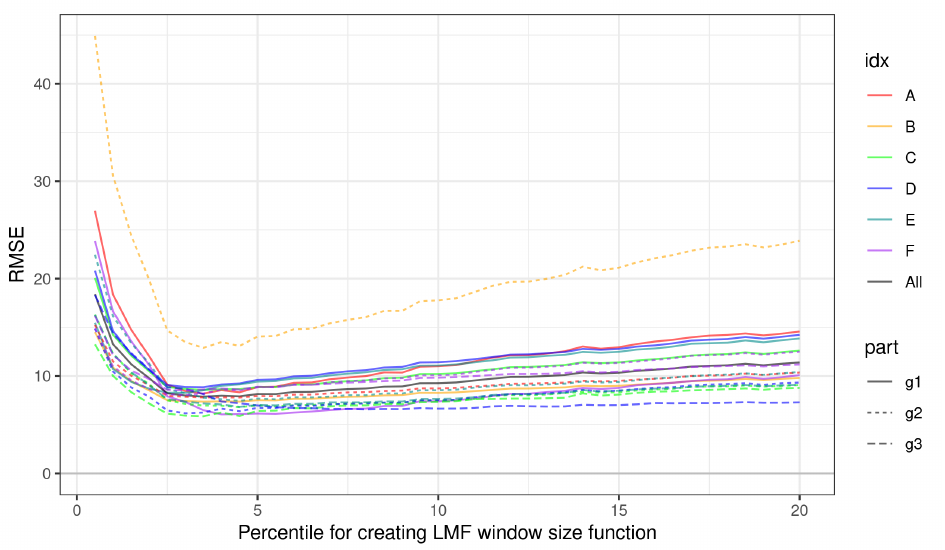
Figure 13. Variability of the RMSE metric for Local Maximum Filter (LMF) method as a function of crown diameter percentile including sample plot categories and groups (A–F, g1–g3, see Table 2; the ‘All’ group represents the entire set of sample